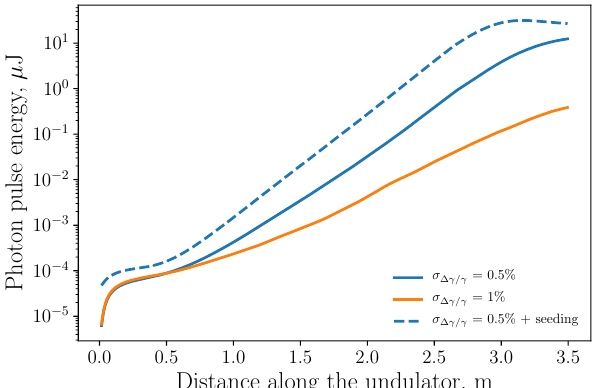
Figure 5. Photon pulse energy amplification for different projected energy spread in the case of the optimized decompressor